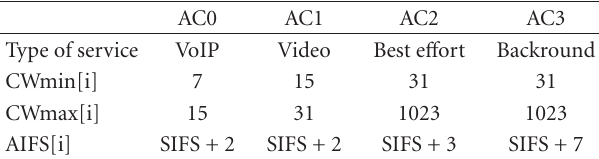
Table 1: 802.11e EDCA standard